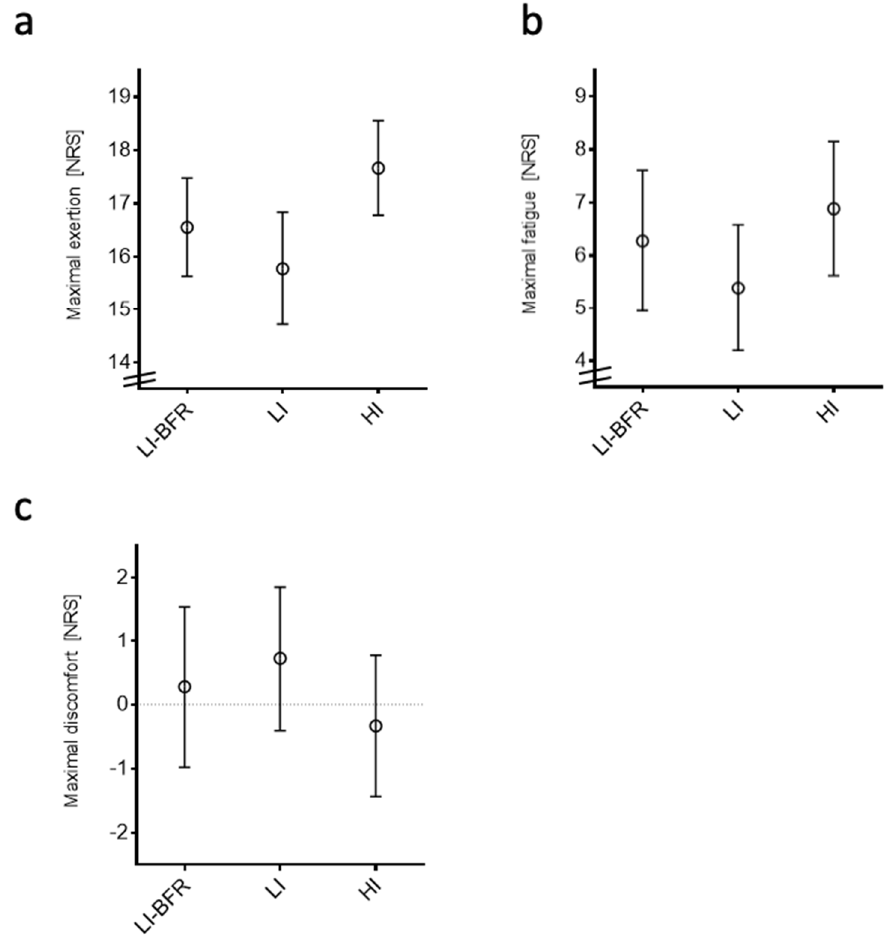
Figure 3. Participant-reported outcomes of training interventions. Data are displayed as mean and 95% confidence intervals. ( a ) Maximal exertion. ( b ) Maximal fatigue. ( c ) Maximal discomfort. NRS, numeric rating scale; LI-BFR, low-intensity training with blood flow restriction; LI, low-intensity training; HI, high-intensity training.